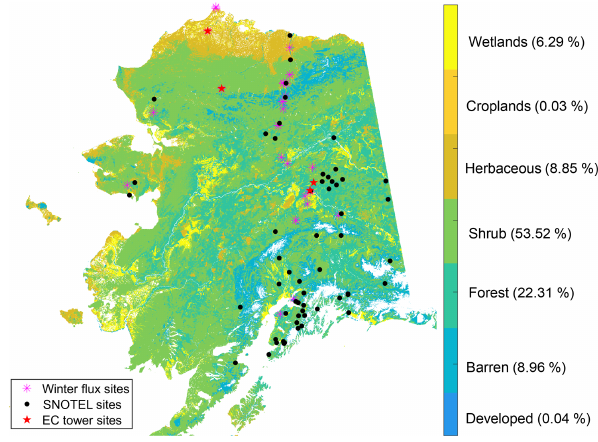
Figure 2. The Alaskan land cover map and the location of in situ sites used for model validation. The land cover types are aggre- gated from the 30m NLCD map (Jin et al., 2013), while the fol- lowing land cover classes were used in the model simulations: de- veloped and barren land, forest, scrub/shrub, grassland/herbaceous, croplands, and wetlands. The percentage of each land cover type is provided alongside the color bar legend